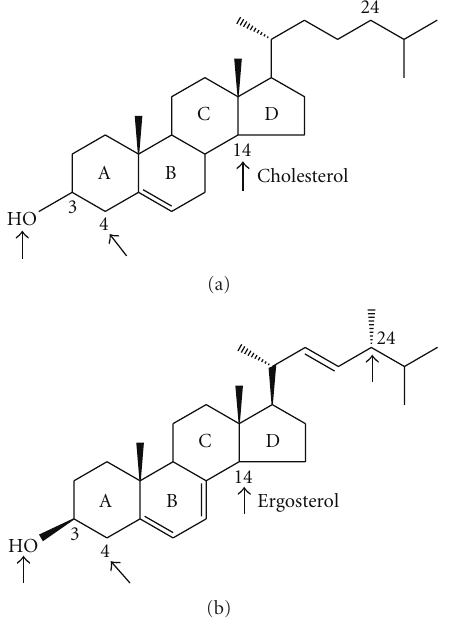
Figure 1: Molecular structures of cholesterol and ergosterol. The arrows indicate the parts of the molecules which have been shown to be essential for the growth of mammalian cells (cholesterol), fungi, and trypanosomatids (ergosterol and 24-methyl sterols).